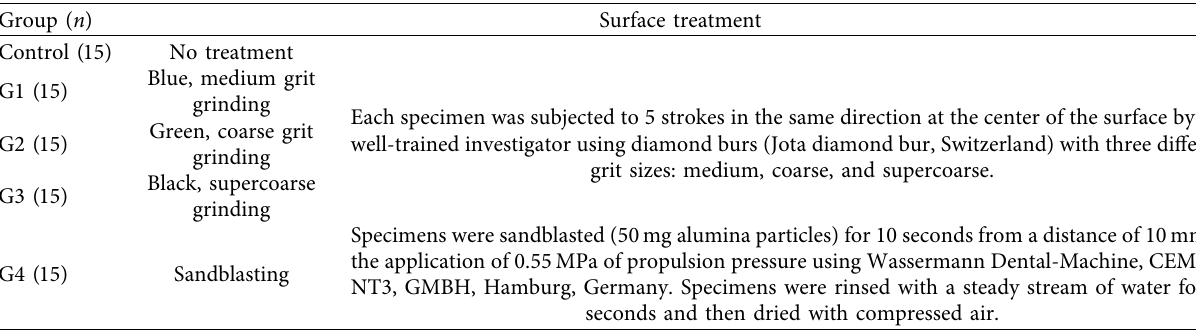
Table 1: Specimens grouping according surface treatment and treatment procedures.